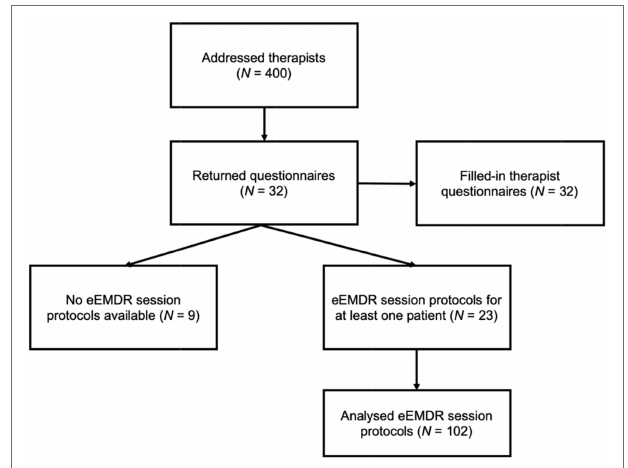
FIGURE 3 | Therapist and session flow